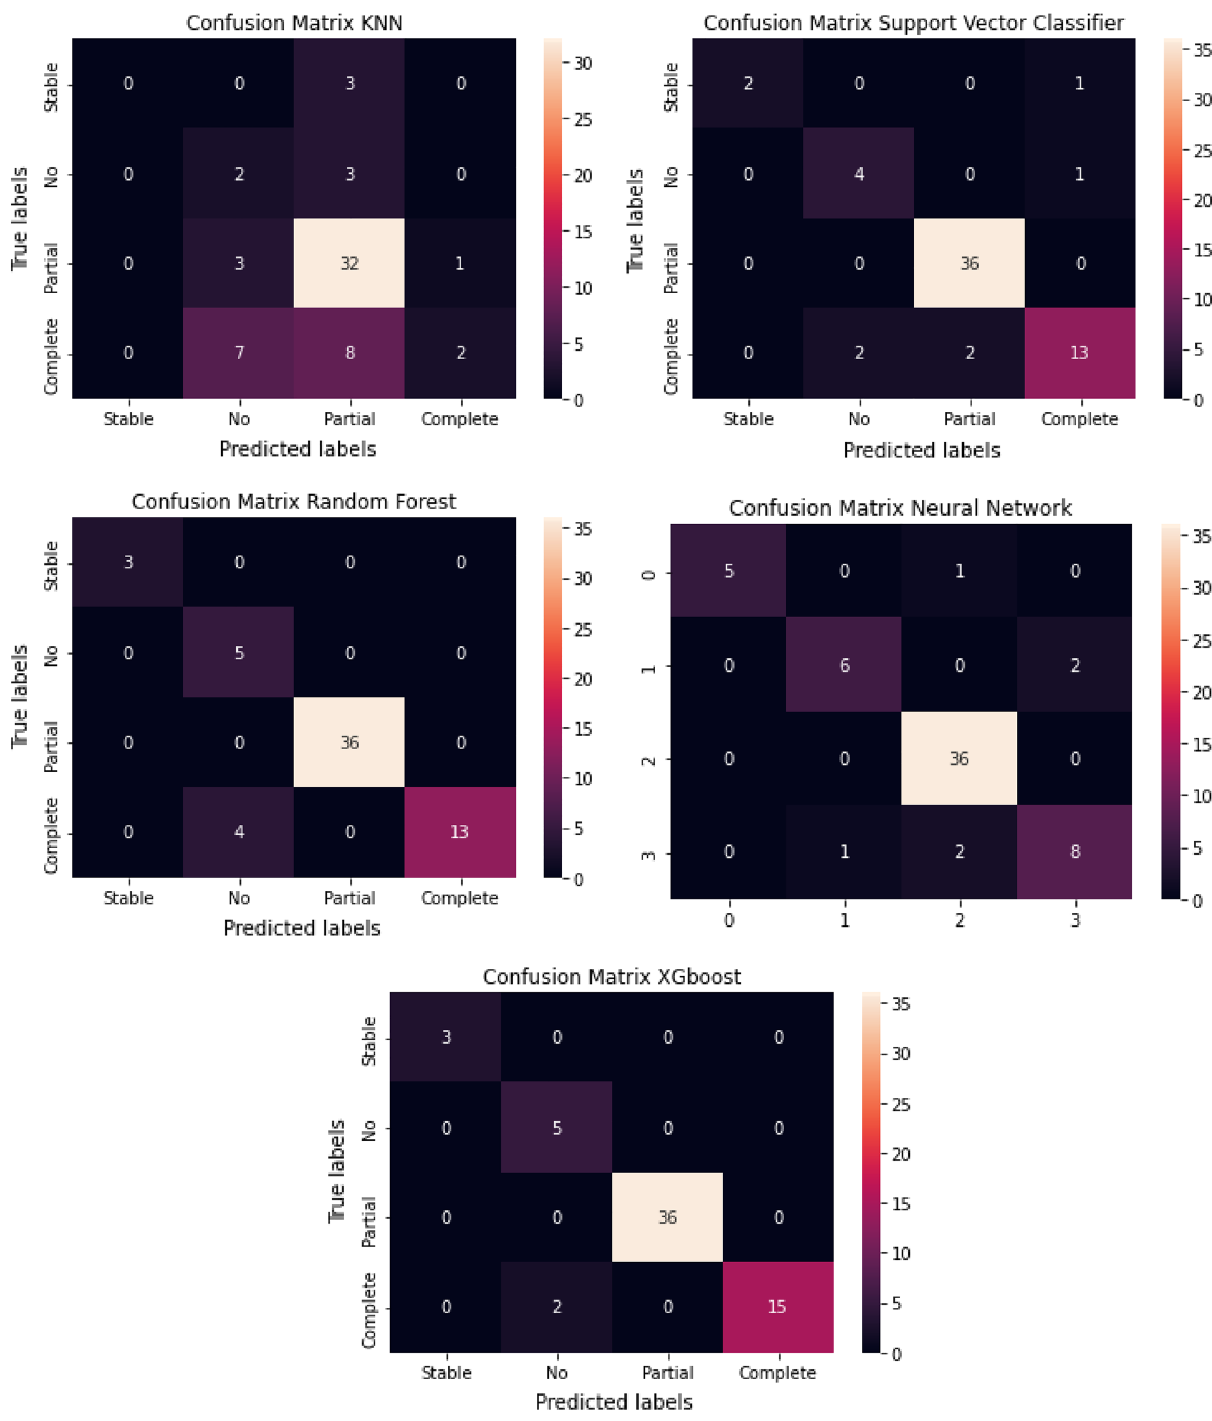
Figure 7. Confusion matrix for testing